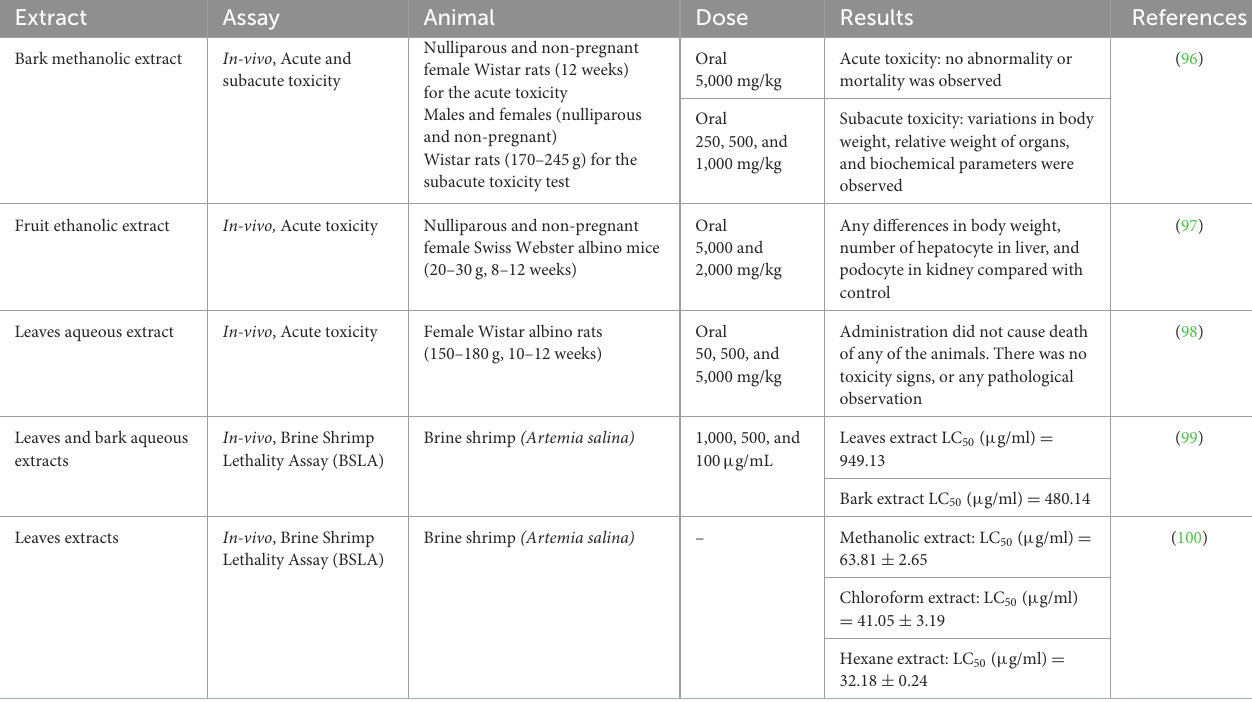
TABLE 6 Toxicological evaluation of extracts of Psidium guajava